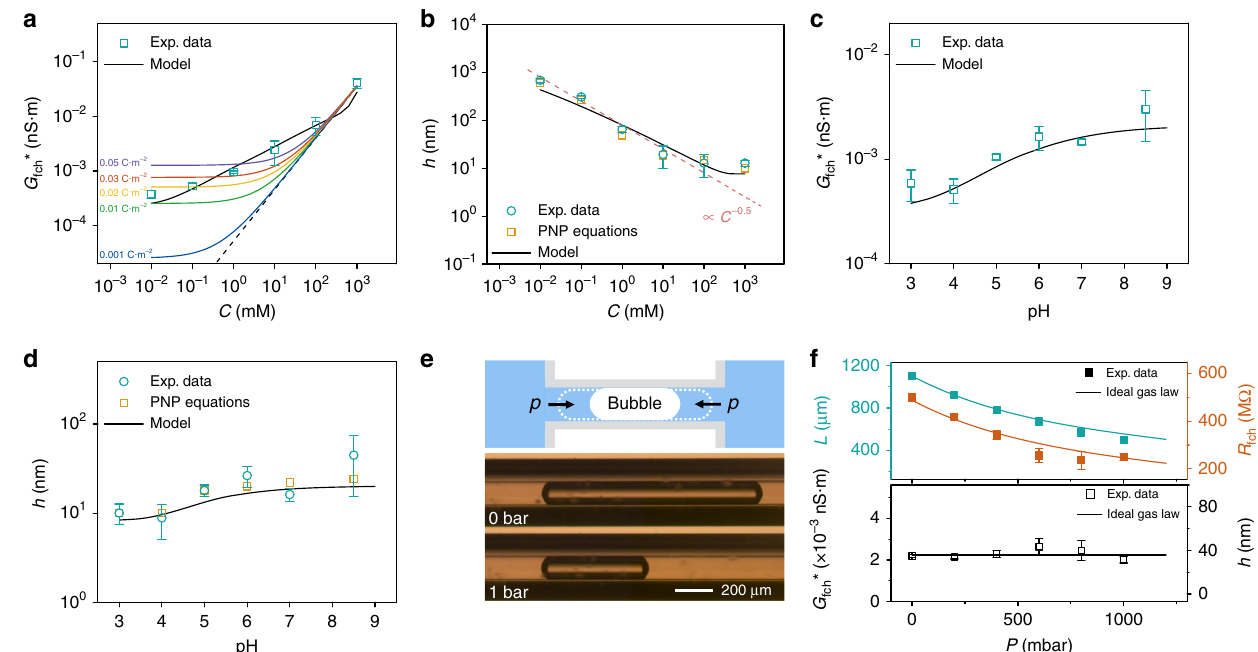
Fig. 3 The tunable height and length of fi lm nanochannel with characterizations. a The measured conductance of fi lm nanochannel per unit length at pH 8.5 (dots), with theoretical predictions (black solid line). The colored lines are theoretical conductance of a fi ctitious solid-state nanochannel with different surface charge densities and a height of 11 nm. b The calculated fi lm thickness from the normalized conductance as a function of KCl concentration at pH 8.5 by theoretical approach (circle dots) and simulations by PNP equations (square dots). Dashed line shows the dependence of the Debye length on concentration. c The normalized conductance with 10 mM KCl solution. d The calculated fi lm thickness as a function of pH at 10 mM solutions. Solid lines are the theoretical predictions described in Methods section. e Bubble shrinkage by applied pressure. The length of the fi lm channel decreases with increasing external pressure of liquid phase. Snapshot of a single gas bubble when the applied external pressure increases from 0 to 1 bar. The length decreases to nearly half value when 1 bar pressure applied on the microchannel. f The decrease of bubble-length (upper graph, green squares)-induced decrease of fi lm nanochannel resistance (upper graph, orange squares) as a function of applied pressure. Solid lines were derived from Eq. 1 with length predicted by Ideal Gas Law. The normalized resistance of fi lm nanochannel (lower graph, dots) and channel height (lower graph, dots) remain constant due to the persistence of capillary pressure (contact angle of bubble). The error bars are the standard deviation of fi ve or more individual